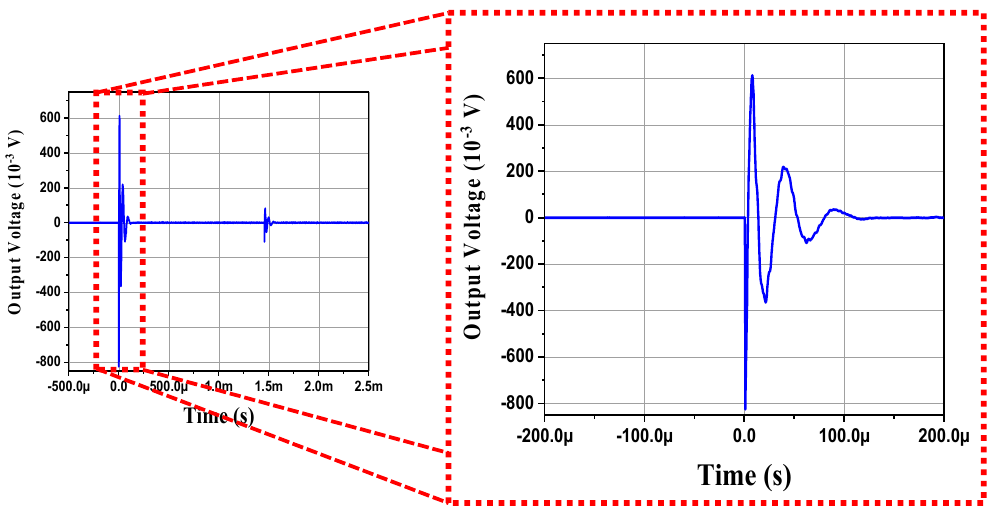
Figure 10. Output voltage of the AE sensor.